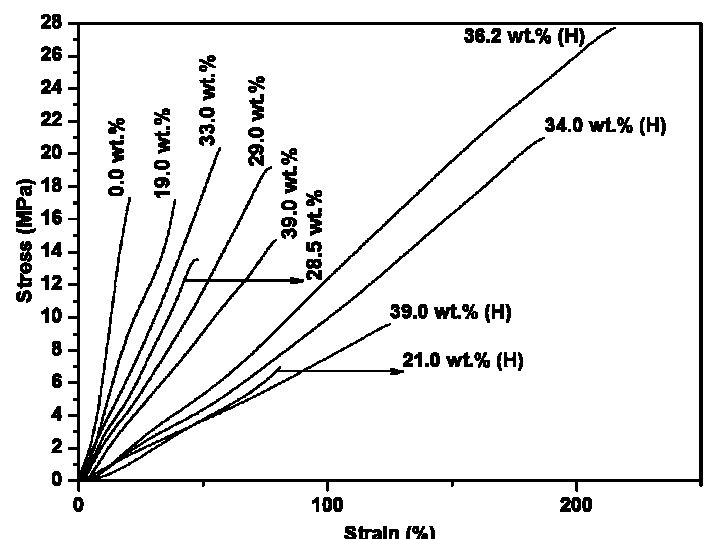
Figure 11. Characterization of mechanical properties-tensile properties (stress vs. strain)